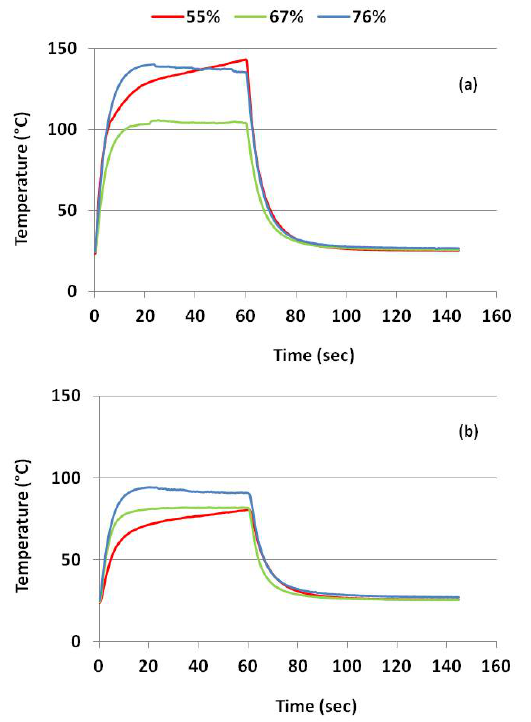
Figure 6. Surface temperature profiles for nickel powder compacts with various initial green densities sintered with CATS at a distance ( a ) ~2.5 mm and ( b ) ~4.5 away from the tip